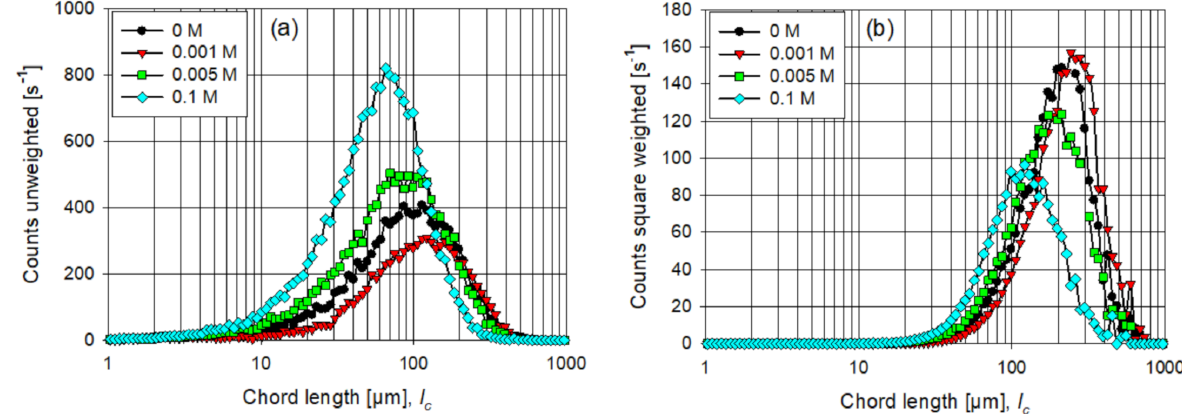
Figure 7. Unweighted ( a ) and squared-weighted ( b ) size distribution of kaolin suspensions for different salinities after three minutes of